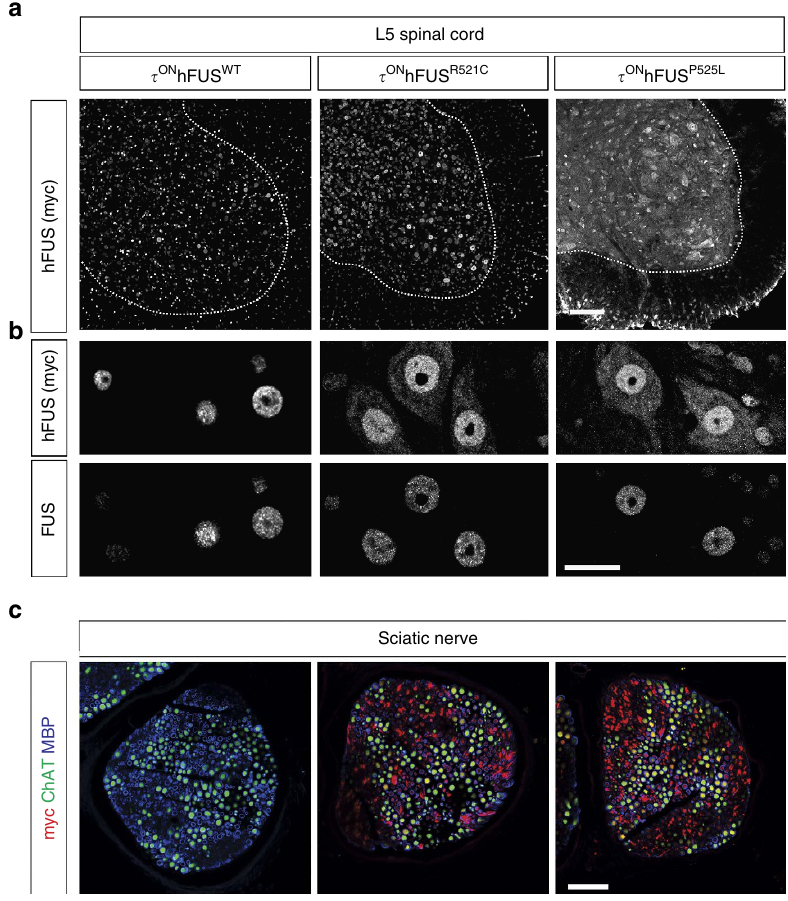
Figure 2 | Diffuse cytoplasmic mislocalization of mutant FUS extends to sensory and motor axons in the peripheral nerve. ( a ) Confocal images of L5 spinal cord cross-sections of hFUS WT (left), ALS mutant R521C (centre) and P525L (right) animals immunostained with anti-myc and anti-FUS antibodies. hFUS was detected by anti-myc antibodies in both the grey and the white matter (boundary marked by the dotted white line), consistent with the normal pattern of Tau ( MAPT ) expression in all neurons and in subpopulations of glia, including oligodendroglia and astrocytes 25–27 . Scale bar, 100 m m. ( b ) Higher magnification confocal images of L5 MNs, as in a . hFUS-WT protein was detected with anti-myc antibody (top, left) exclusively in the nucleus, whereas hFUS-R521C (top, centre) and hFUS-P525L (top, right) were detected both in the nucleus and in the cytoplasm of the MNs. Immunohistochemical staining with anti-FUS antibody (bottom) detected nuclear but not cytoplasmic FUS in all samples. Scale bar, 25 m m. ( c ) Cross-sections of sciatic nerves stained with anti-myc (red), anti-ChAT (green) and anti-MBP (myelin basic protein, blue) antibodies. hFUS-R521C and hFUS-P525L proteins, but not hFUS-WT, were detected in motor and sensory axons in the peripheral sciatic nerve. Scale bar, 40 m